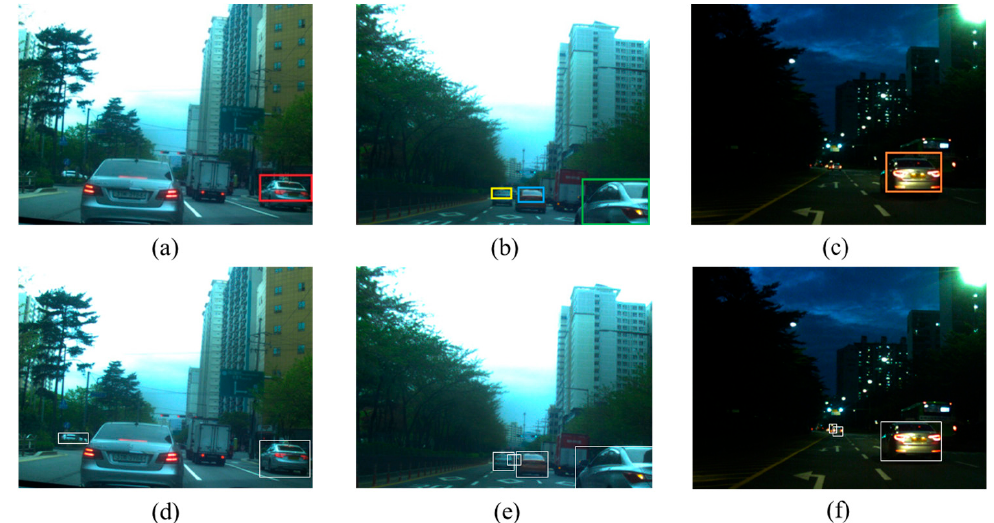
Figure 8. Bounding box on the example images. ( a ) Proposed method on example image 1; ( b ) proposed method on example image 2; ( c ) proposed method on example image 3; ( d ) ground truth of example image 1; ( e ) ground truth of example image 2; ( f ) ground truth of example image 3.